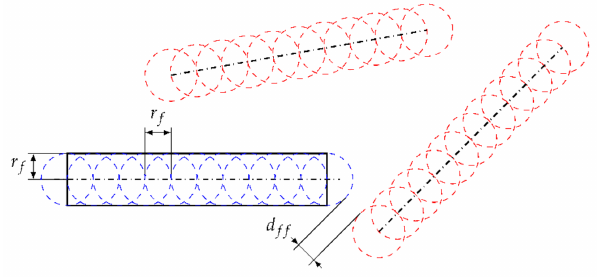
Figure 5. Test of intersection between new (blue) and existing (red) fibers.